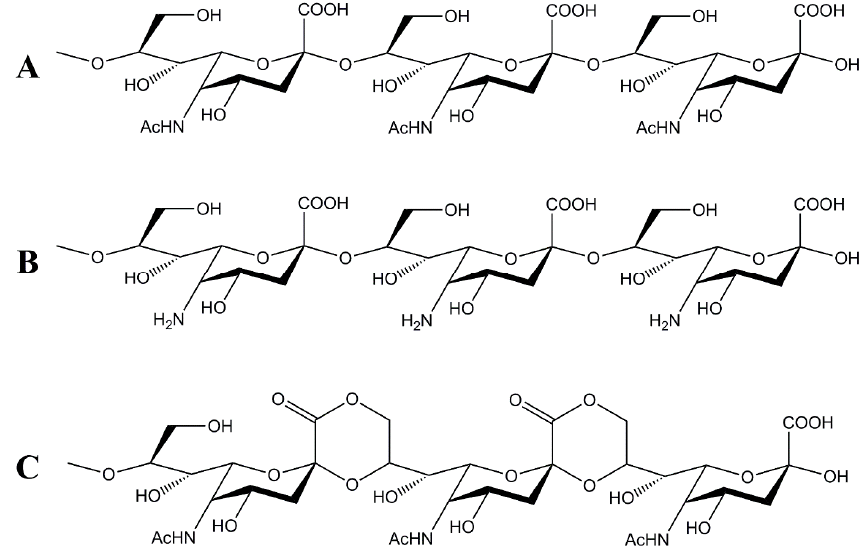
Figure 1. Chemical structure of α -(2,8)-linked derivates of polysialic acid: ( A ) structure of the homopolymer of α -(2,8)-linked 5-N-acetylneuraminic acid (polySia), ( B ) homopolymer of α -(2,8)-linked neuraminic acid, and ( C ) the lactonized structure of α -(2,8)-linked polySia. The polysaccharide masks the underlying cellular surface molecules of the pathogens [3]. The